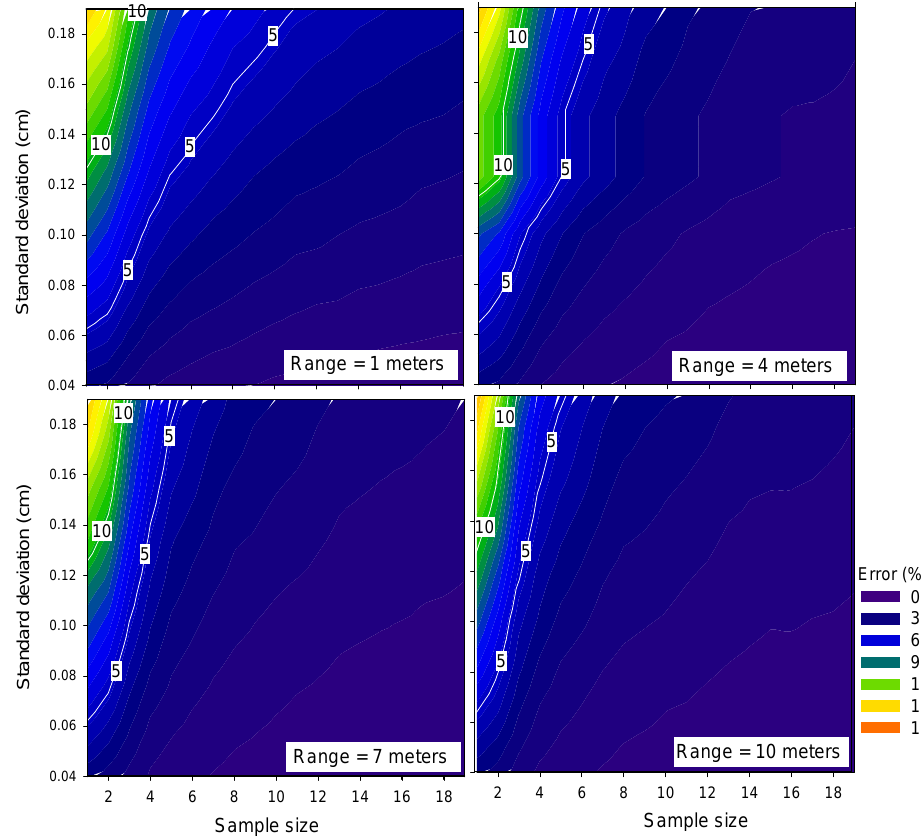
Figure 6. 5 Fig. 6. Average error for various sample sizes derived from simulated plots according to various standard deviation levels and 4 classes of spatial